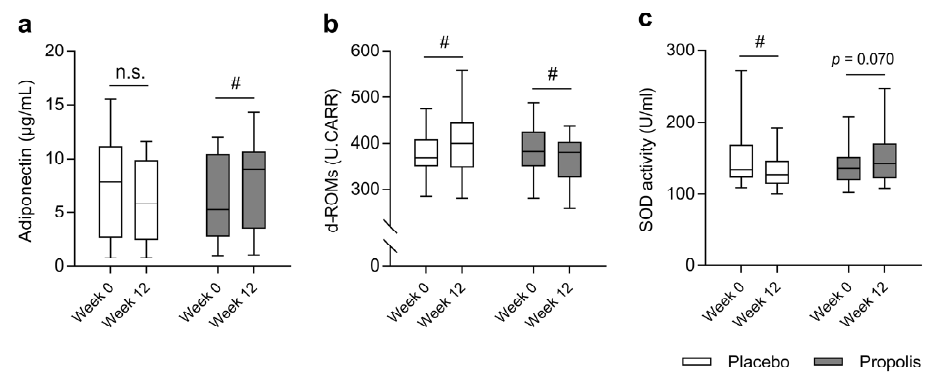
Figure 3. Boxplots showing values of serum levels of adiponectin ( a ), blood levels of d-ROMs ( b ), and serum SOD activity ( c ) before and after the intervention in the placebo (white) and propolis (gray) groups. Boxplots show the median, upper and lower quartiles, and maximum and minimum values. The differences between before and after the intervention in each group were compared using a Mann–Whitney U -test. A p value of <0.05 was considered significant. # Significantly different between before and after the intervention. d-ROMs, diacron-reactive oxygen metabolites; SOD, superoxide dismutase.